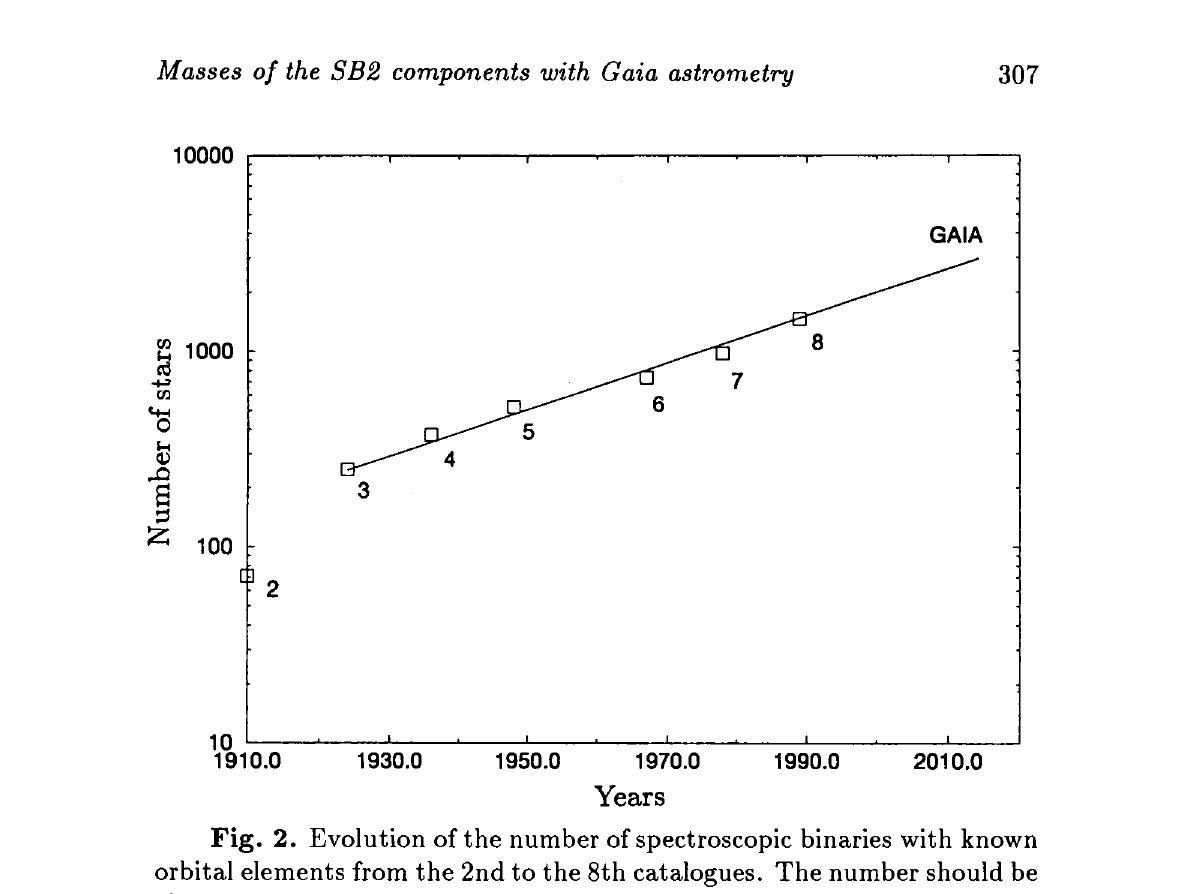
Fig. 2. Evolution of the number of spectroscopic binaries with known orbital elements from the 2nd to the 8th catalogues. The number should be about 3000 in 2015, when the reduction of the Gaia data will be